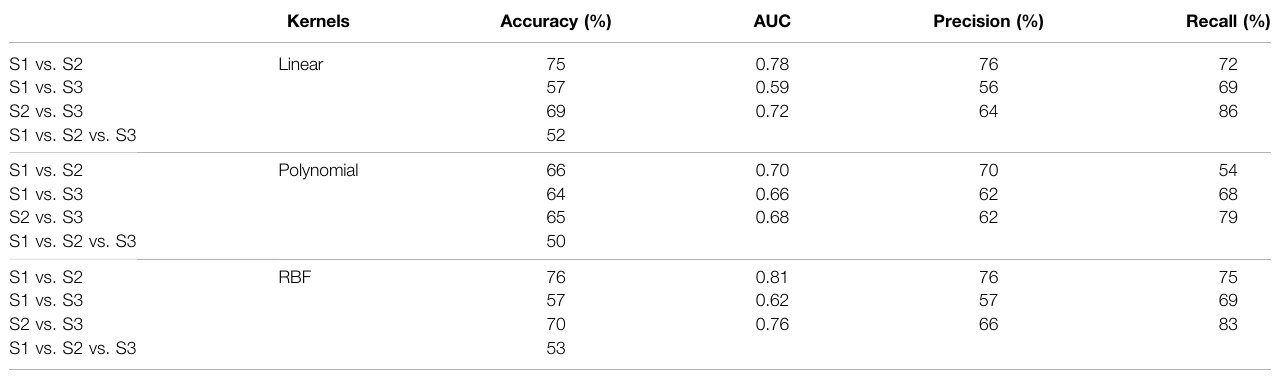
TABLE 1 | Emotion change in different events using wavelet-based feature extraction under SVM classi fi er.